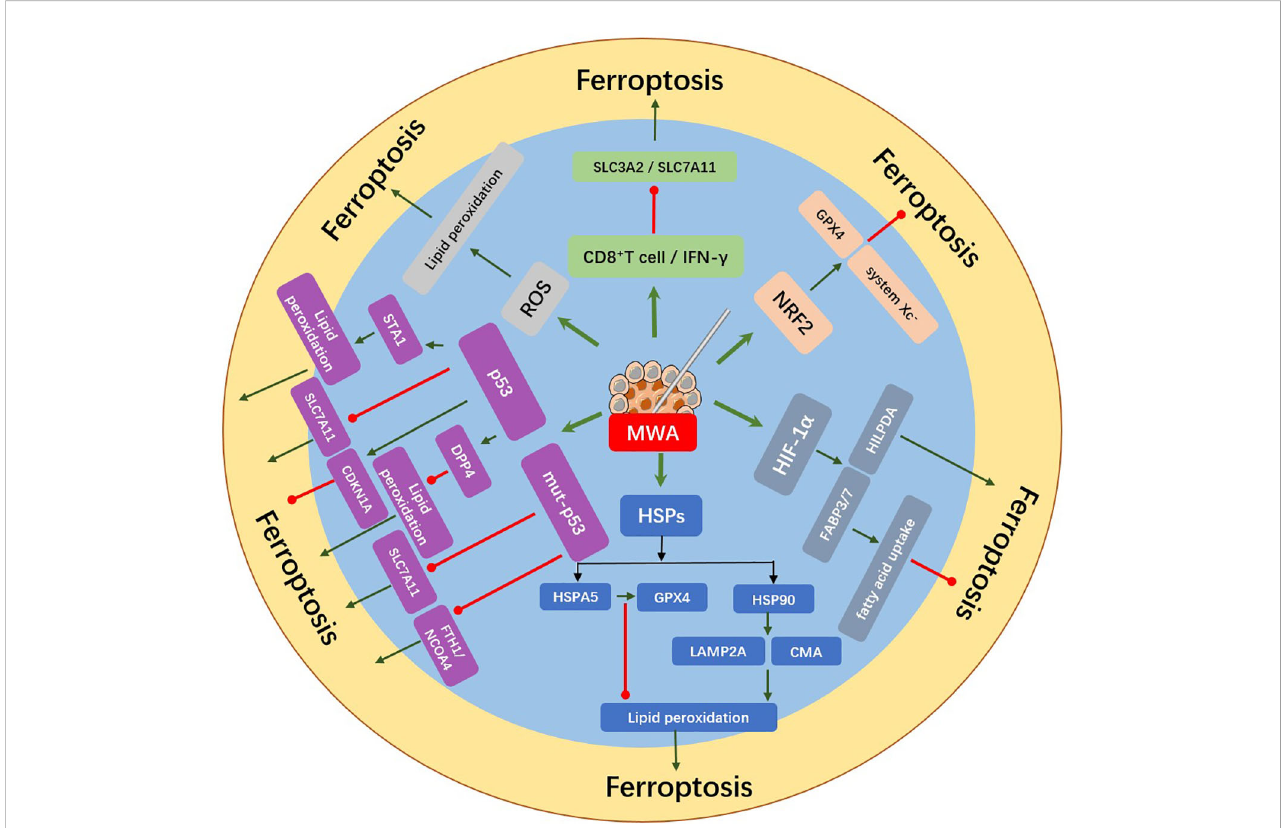
FIGURE 2 MWA induced the release of ferroptosis-related molecules from tumor cells. Upregulation of ROS, HIF-1 a , HSPs, p53, NRF2, CD8 + T cell, and IFN- g after MWA might regulate the occurrence of ferroptosis. MWA can induce lipid peroxidation by producing excessive ROS, which may further induce ferroptosis. p53 can induce ferroptosis by inhibiting SLC7A11 or promoting the activation of SAT1 and it can also inhibit ferroptosis by combining DPP4 or inducing the expression of CDKN1A. Mut-p53 can induce the sensitivity of ferroptosis by inhibiting the expression of SLC7A11 and FTH1/NCOA4. MWA upregulates HSPs expression. HSP90 can promote ferroptosis by regulating the stability of LAMP2A and CMA, while HSPA5 can inhibit ferroptosis by protecting GPX4 degradation. HIF-1 a increases the expression of FABP3/7 and inhibits ferroptosis via promoting fatty acid uptake. The expression of HILPDA can promote ferroptosis. NRF2 can inhibit ferroptosis by promoting system Xc - and GPX4. IFN- g secreted by CD8 + T cells reduces SLC3A2 and SLC7A11, thus promoting lipid peroxidation and